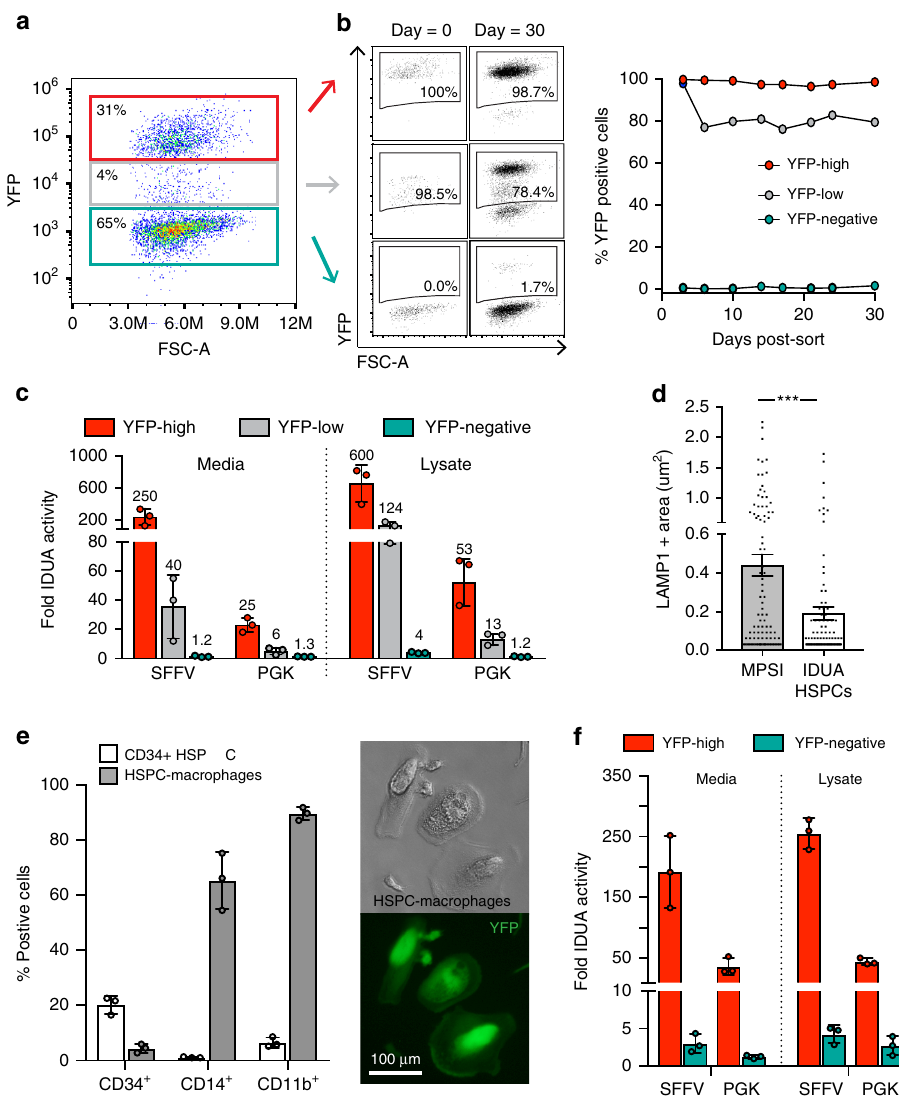
Fig. 2 Enhanced IDUA expression by IDUA-HSPCs and derived macrophages. a Representative FACS plot showing three distinct populations based on YFP expression 3 days post-modi fi cation. b Percent YFP-positive cells in culture (30 days). c , Fold increase in IDUA secretion and intracellular expression by YFP-high, YFP-low, and YFP-negative populations compared to mock cells. d , Average LAMP-1 + area in MPSI fi broblasts co-cultured with IDUA-HSPCs. Each dot represents a cell. e , Human CD34, CD14, and CD11b marker expression in HSPC-derived macrophages after in vitro differentiation compared to undifferentiated cells (CD34 + HSPCs). Macrophage morphology and YFP expression after differentiation. f , Fold increase in IDUA secretion and intracellular expression in HSPC-macrophages modi fi ed with SFFV and PGK expression cassettes. c, e, f , Each column represents average of triplicates in n = 3 independent biological samples. All data expressed as mean ± SD, *** p < .001 in two-sided unpaired t-test. Source data are provided as a